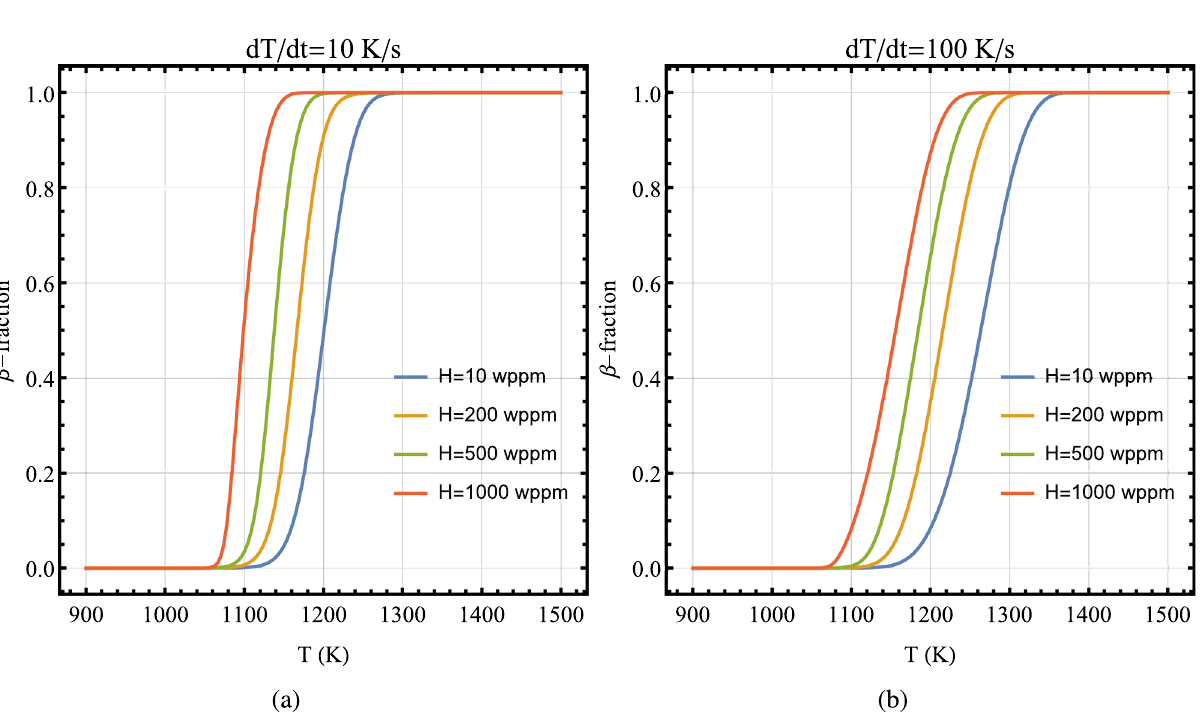
Figure 11. Volume fraction of β -phase as a function of temperature for several values of hydrogen concentrations in Zircaloy-4 calculated by using model B at heating rates: ( a ) 10 K/s and ( b ) 100